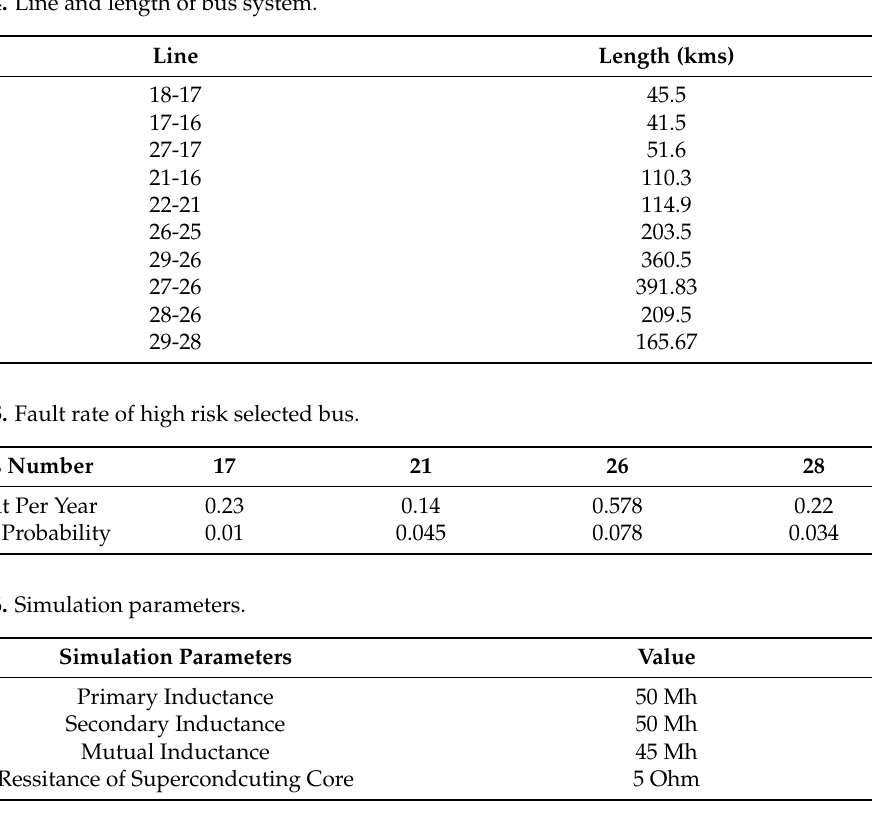
Table 4. Line and length of bus system.